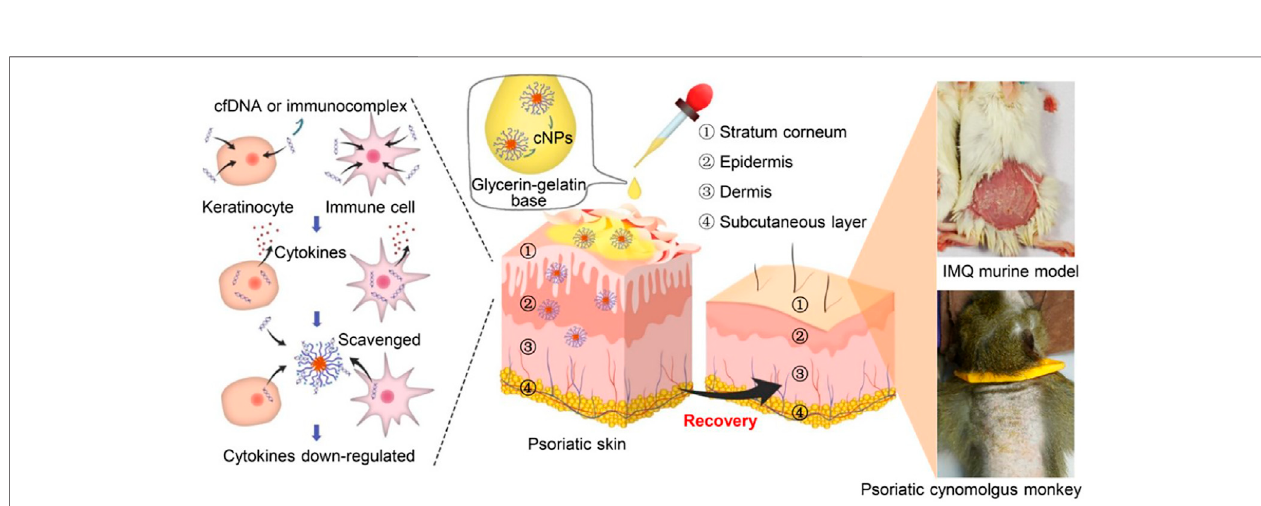
FIGURE 6 | Mechanism of topical administration of PLGA-b-PDMA on psoriasiform skin in both mouse model and cynomolgus monkey model by competing for DNA from the DNA-LL37 immunocomplex and suppressing DNA-LL37-induced cell activation (Reprint from Reference (Liang et al., 2020)).